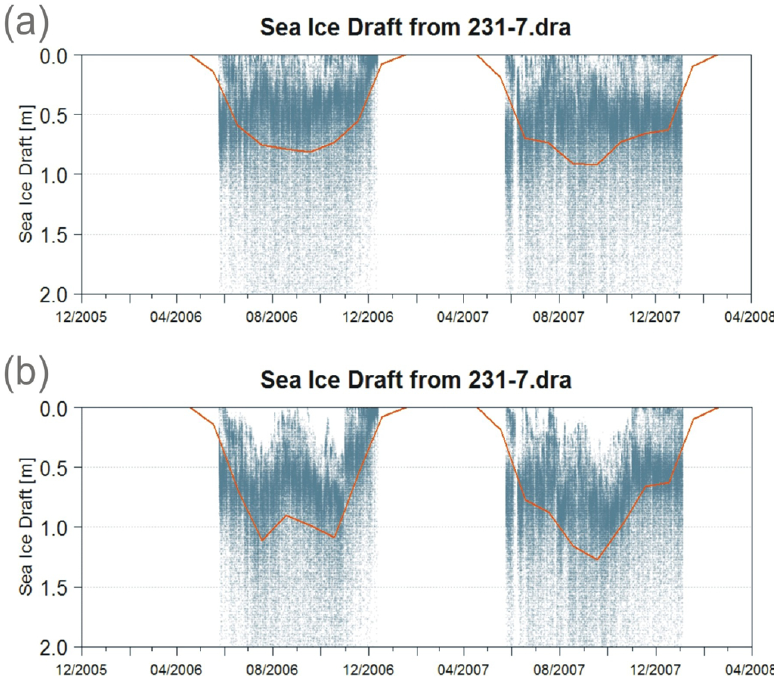
Figure 9. (a) Ice draft of AWI 231-7, corrected by zero-line interpolation. (b) The same ice draft, but with the months June–October corrected by the sound speed model (incl. pressure drift correction) and the remaining months by zero-line interpolation. The solid lines are monthly mean ice drafts.